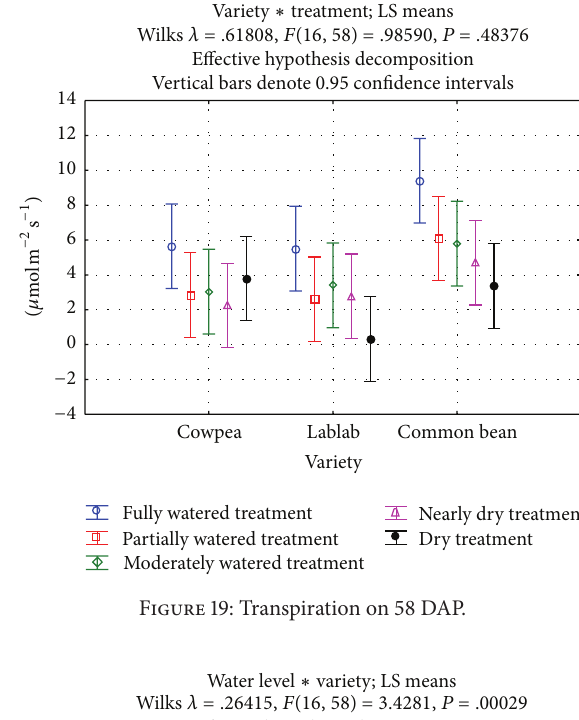
Figure 17: Stomatal conductance on 58 DAP.